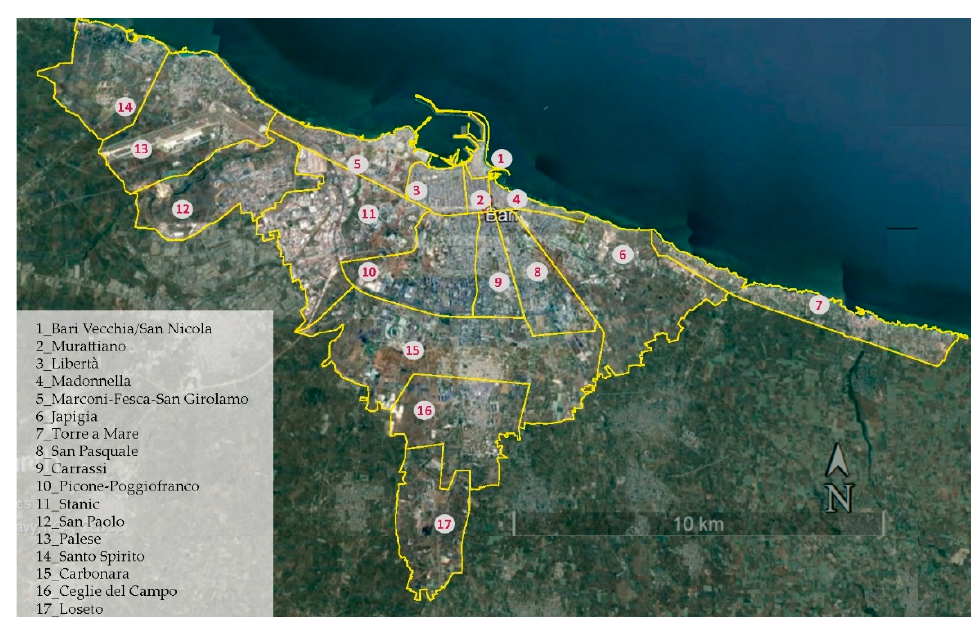
Figure 4. Districts of Bari.